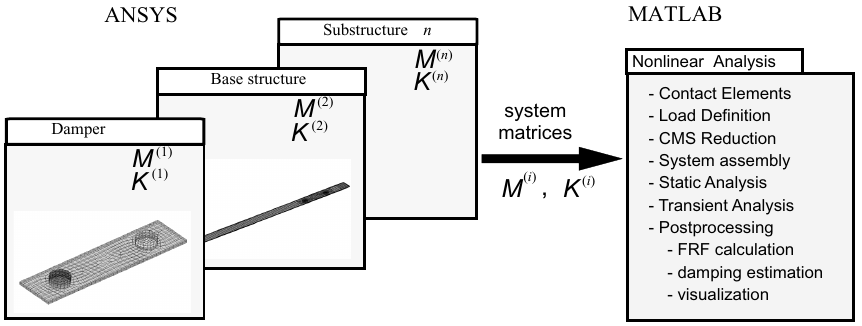
Fig. 8. Simulation framework for nonlinear structural analysis of mechanical structures with friction.